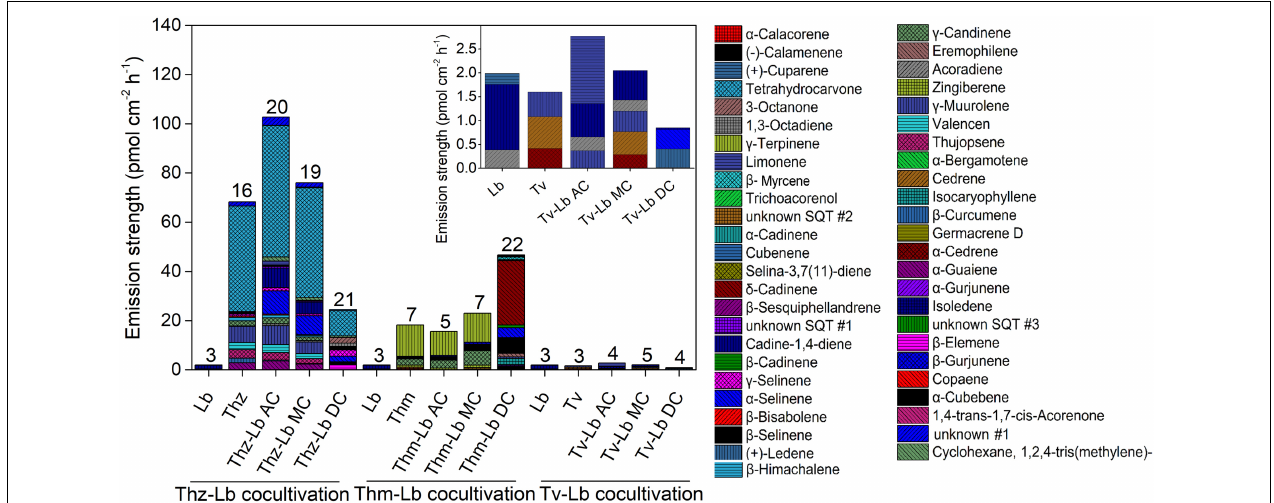
FIGURE 5 | The volatile organic compound profiles of T. harzianum (Thz), T. hamatum (Thm), T. velutinum (Tv), and L. bicolor (Lb) alone and each Trichoderma strain in different co-cultivation set-ups with Lb. For further information on the abbreviations please see Figure 1 . The numbers on the bars indicate the total individual VOCs detected. Insert: Magnification of the VOC profile of Tv and sole Lb culture. Emission rates of each compound calculated based on the fungal area and collection duration of VOCs; values are means of 6